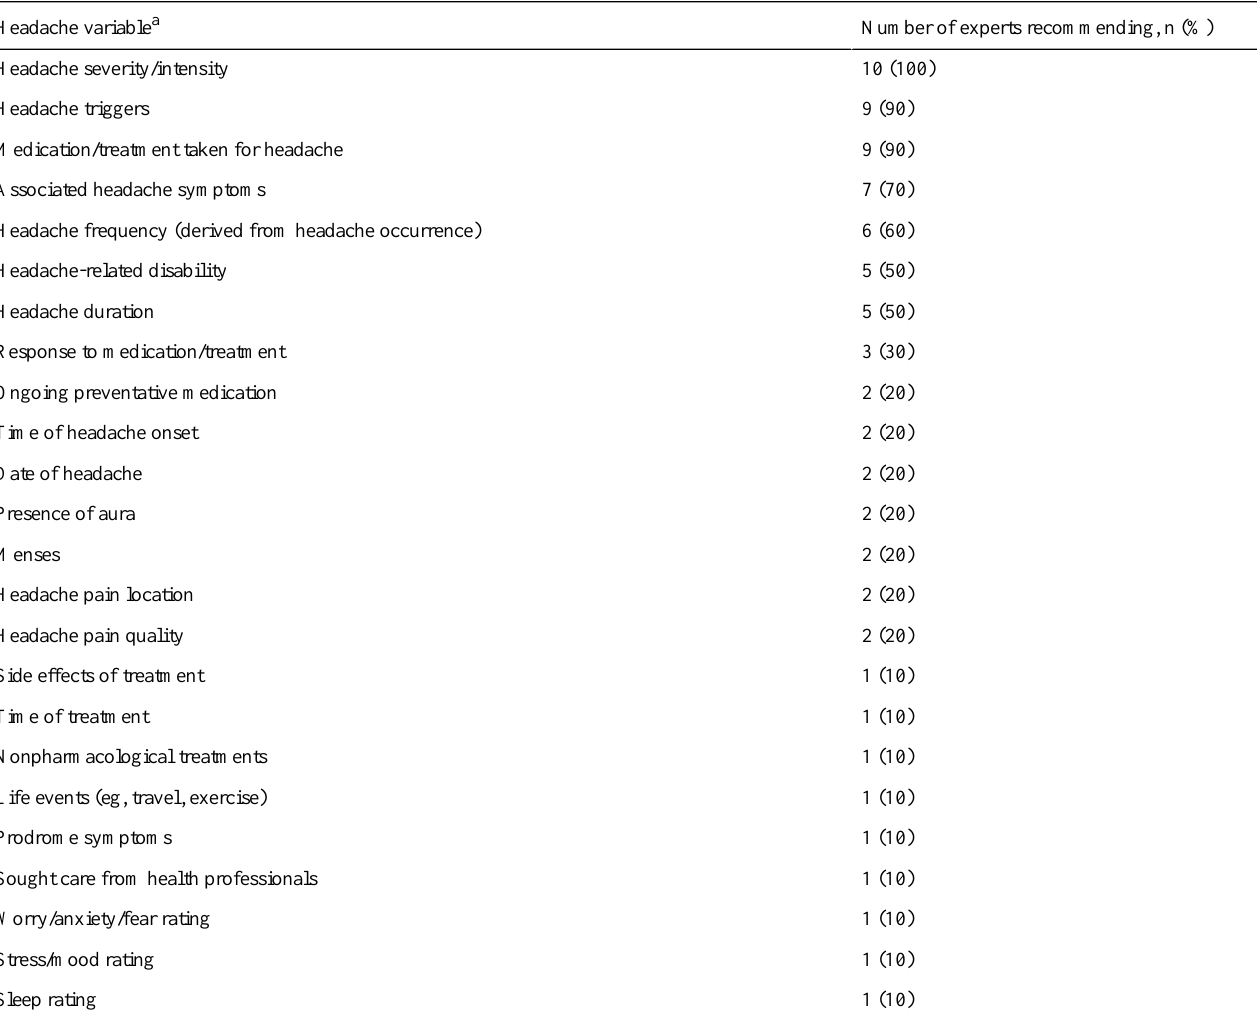
Table 1. Headache variables recommended by headache experts